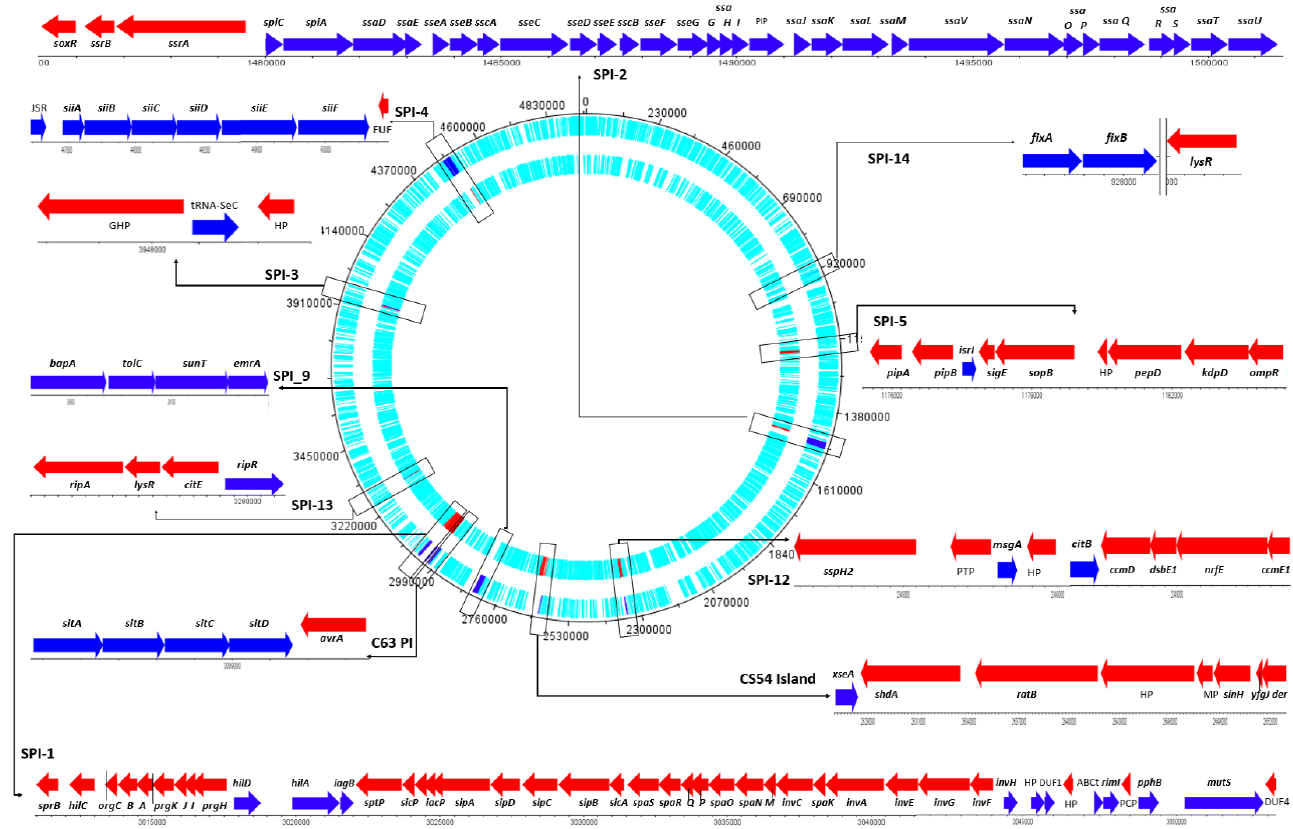
Figure 4. The black line indicates the position on the genome (Kbp); the Salmonella Pathogenity Islands are presented in color: the red arrows indicate genes on the reverse strand and the blue arrows indicate those on the forward strand: SPI-1 includes 38 genes and 5 putative protein genes ( sprB,